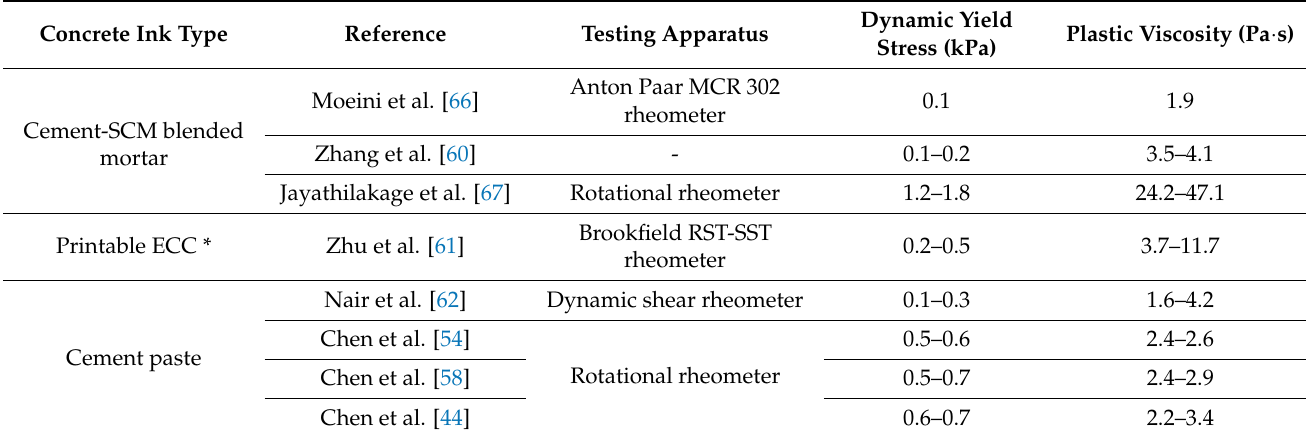
Table 2. Dynamic yield stress and plastic viscosity values reported in literature for different concrete inks.